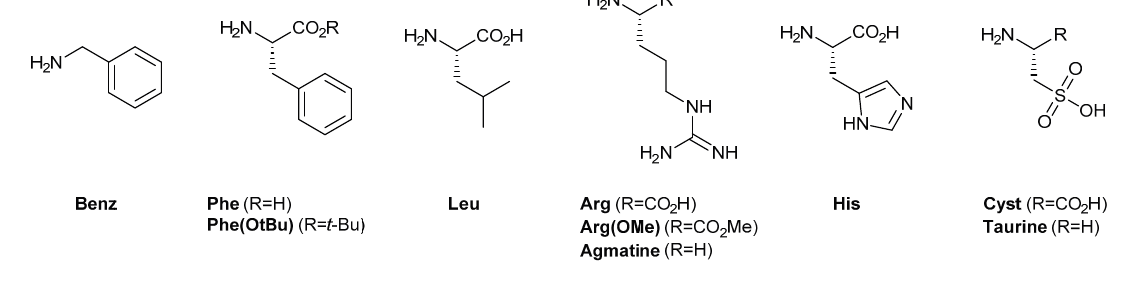
Figure 1. Structures of the amines